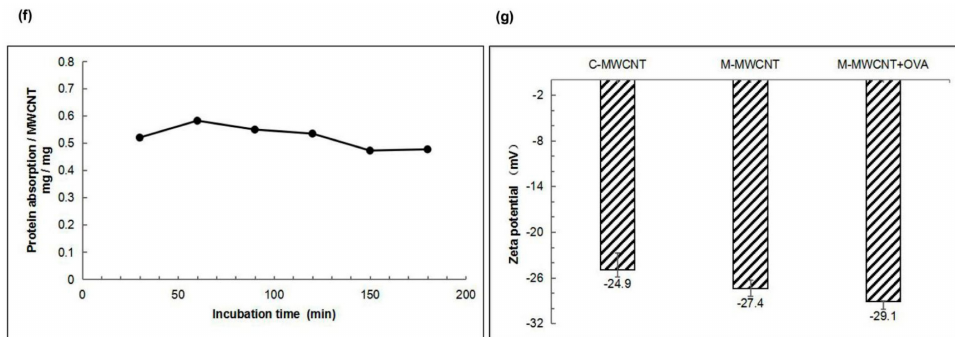
Figure 2. Functionalization and physicochemical characterization of M-MWCNT. ( a ) TEM images of C-MWCNT and M-MWCNT. ( b ) FTIR transmission spectra of C-MWCNT, M-MWCNT, and Mannose. ( c ) TGA curves of C-MWCNTs, M-MWCNT, and mannose. ( d ) UV absorbance spectra of C-MWCNT and M-MWCNT. ( e ) Standard curve of OVA adsorption. ( f ) Kinetics of OVA adsorption on M-MWCNT. ( g ) Zeta potential of M-MWCNT. ( p <